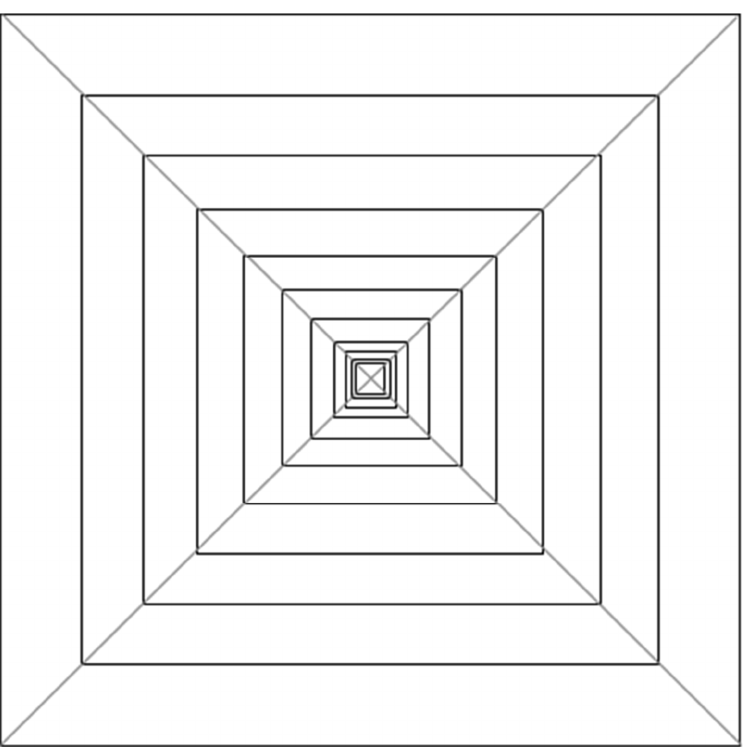
Figure 3. Schematic of experimental stimulus 3 (IP): INCOMPLETE (squares only) HUGHES-TYPE “PERSPECTIVE” GRID.